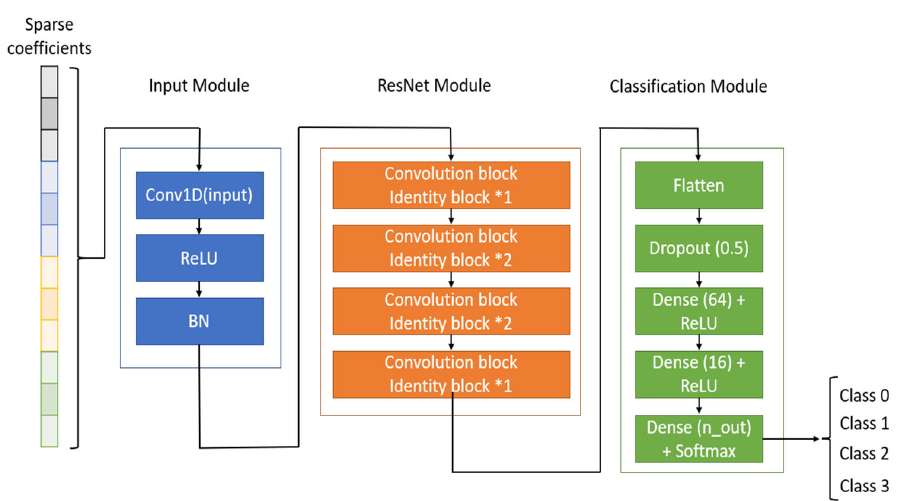
Figure 6. Architecture of 1D-ConvResNet. Three modules: Input module, ResNet module, and classification module. We performed a four-class classification of EEG sparse coefficients. (*) represents the number of blocks of each type.